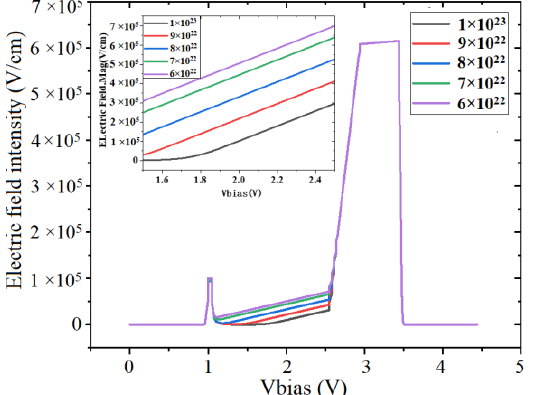
Figure 9. Electric field distribution diagram under different doping concentration of grading layer, doping concentration unit: m − 3 . (Note. The inserted figure is a partial enlargement of Figure 9).